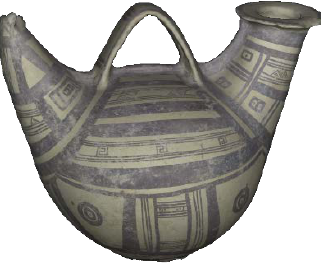
Figura 13 The Askos from T596 inside Meshlab.